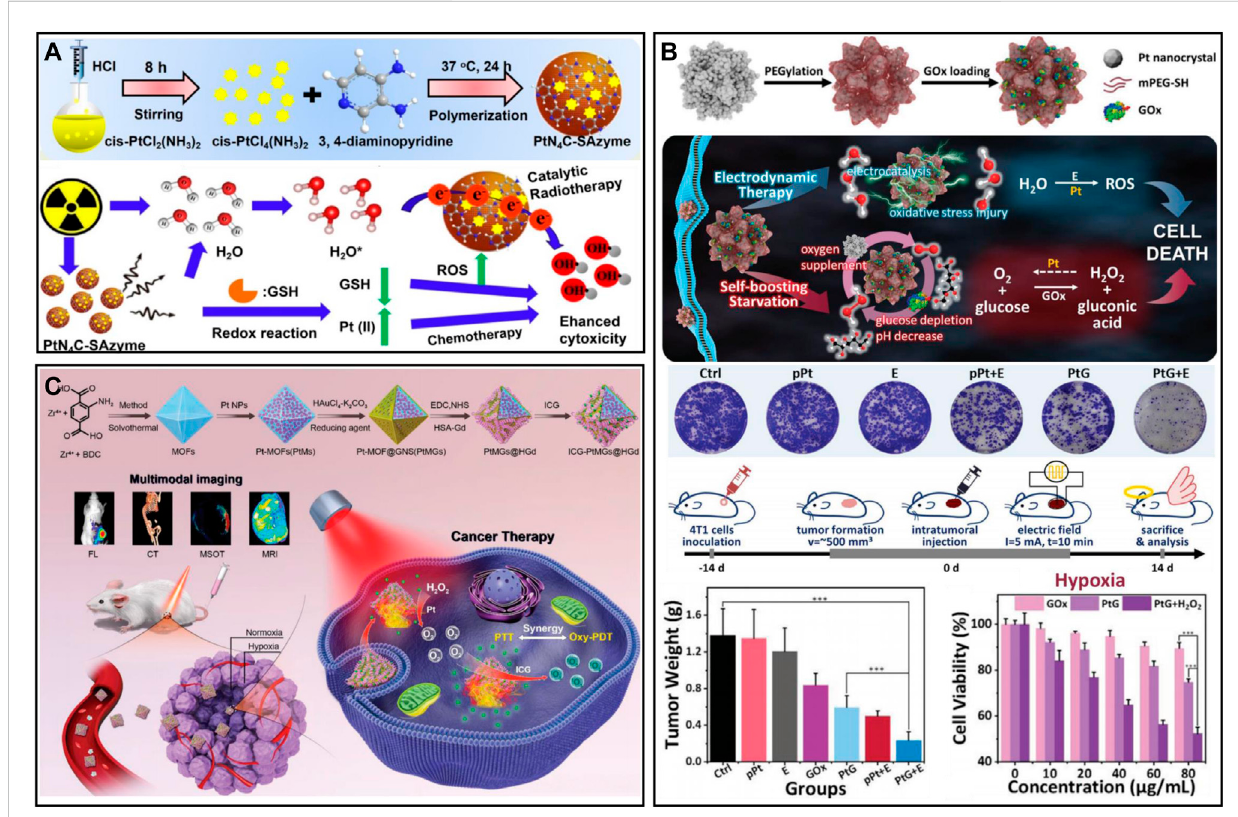
FIGURE 5 (A) PtN 4 C-SAzyme for oxygen self-supplied tumor therapy. Reproduced from ref. (Yang et al., 2017) with permission from Ivyspring International Publisher,copyright2022. (B)